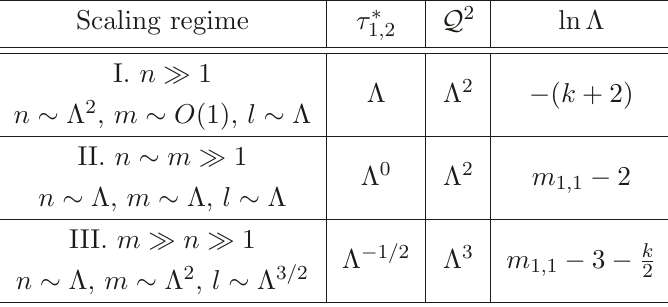
Table 1 . Summary of logarithmic corrections to ln d ( and with maximal polarity D = 1. Here Λ